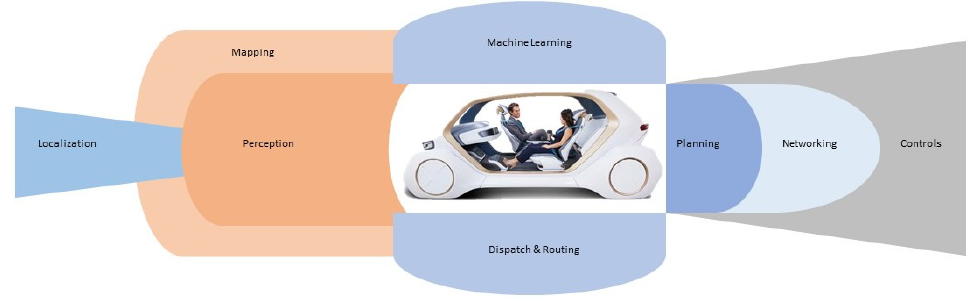
Figure 2. Technologies used in